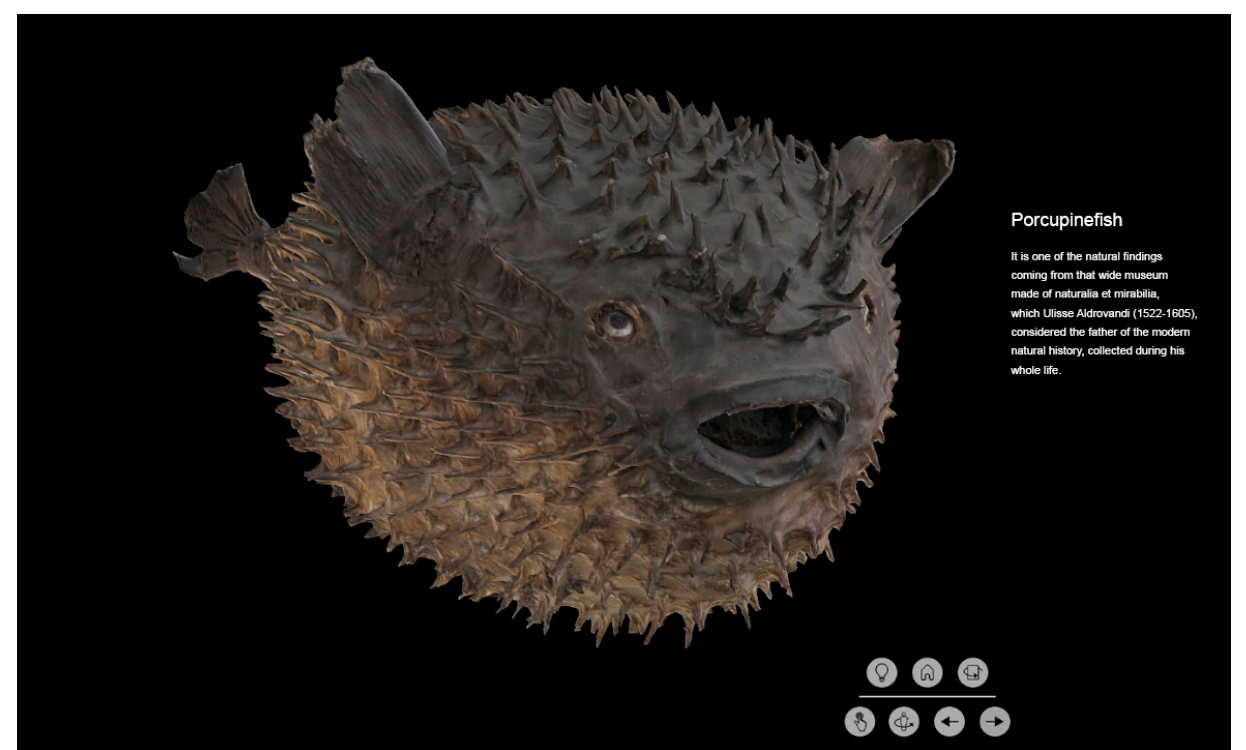
Figure 25. 3D geometry displayed into a RTR environment. The textured model can be explored using a custom graphical user interface specifically developed, in which it can be illuminated by different lights or manipulated through touch gestures.